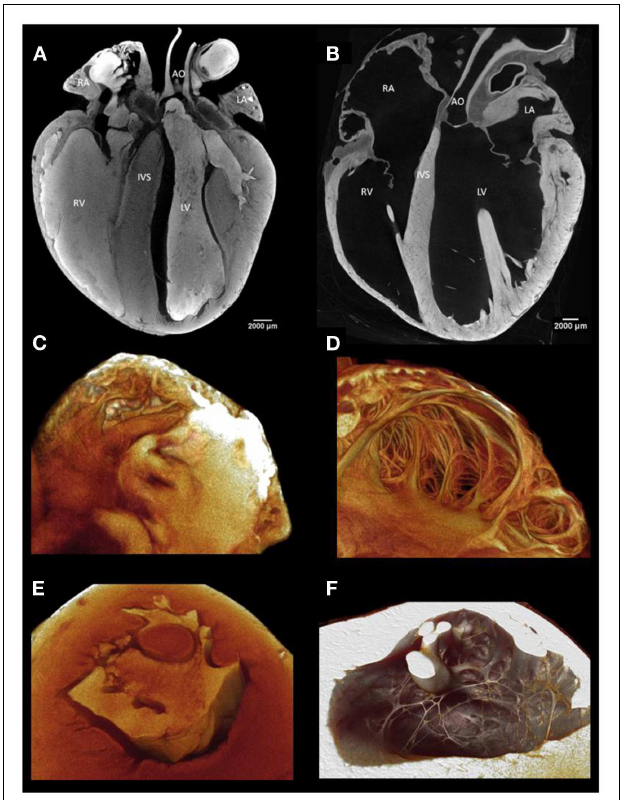
FIGURE 1 | (A) A virtual longitudinal micro-CT section through a fixed rabbit heart stained with iodine contrast agent with blood residing in the cardiac chambers and great vessels.The residing blood shows a high attenuation because it has taken up iodine and thus the internal structure of the ventricular and atrial walls is not easily visualized. (B) This section illustrates the great improvement in anatomical discrimination achieved by removal of the blood by perfusion through the chambers and through the coronary circulation before fixation. Residing blood obscures visualization of the endocardial surface and cavity of atrial (C) and ventricular (E) samples.With careful flushing, perfusion fixation, and infusion with iodine, the endocardial surface and cavity of the atrium (D) and ventricle (F) are demonstrated in fine anatomical